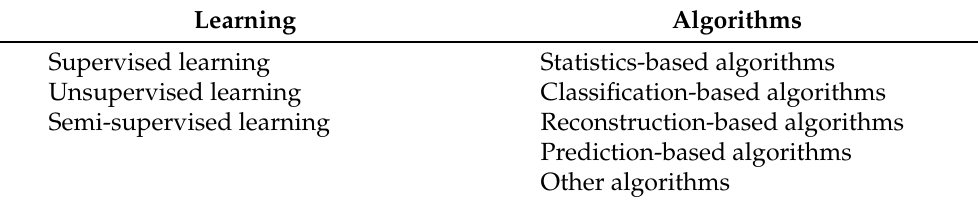
Table 1. Taxonomy for anomaly detection in video